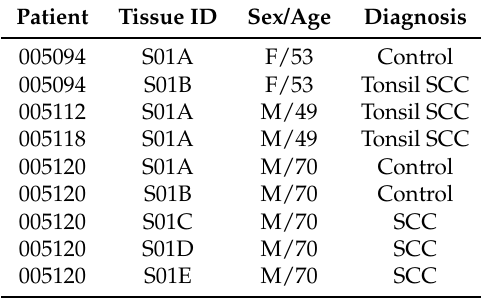
Table 1. Summary of the patient data and tissue type for the samples used in this study.